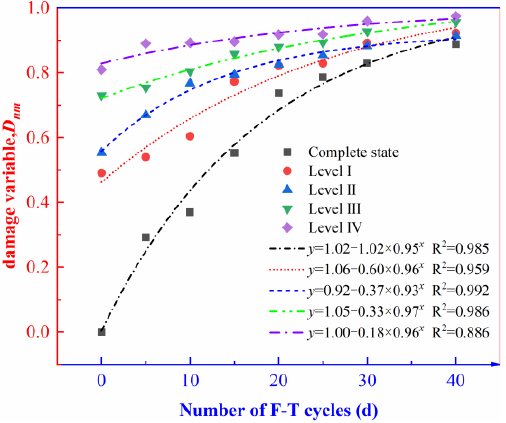
Figure 9. A plot of the number of F-T cycles in function of damage variables due to the F-T effect.